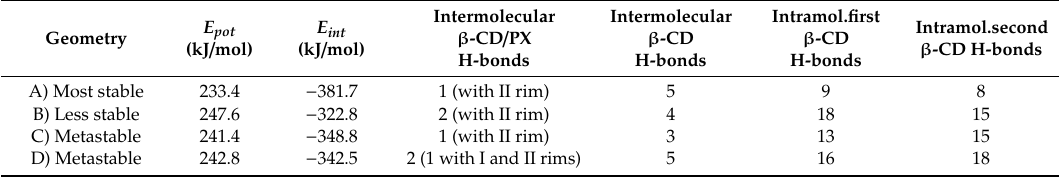
Table 2. Interaction energy of the optimized geometries assumed at the end of the MD runs for the most stable and the less stable final geometries in a 2:1 stoichiometry. Intermolecular β -CD / PX and β -CD H-bonds and intramolecular β -CD H-bonds are also